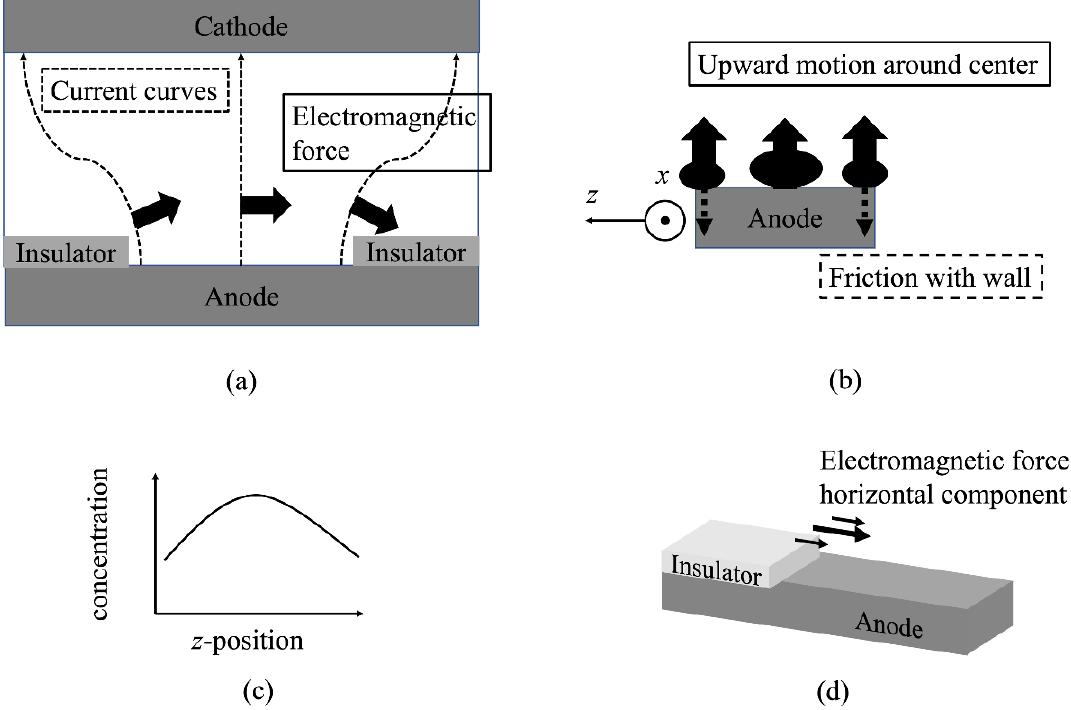
Figure 8. Schematics of ( a ) current and electromagnetic force distributions, ( b ) right side view of upward liquid motion near the left part of the anode surface, ( c ) concentration distribution in the z -direction and ( d ) electromagnetic force horizontal component distribution near the left part of the anode surface.